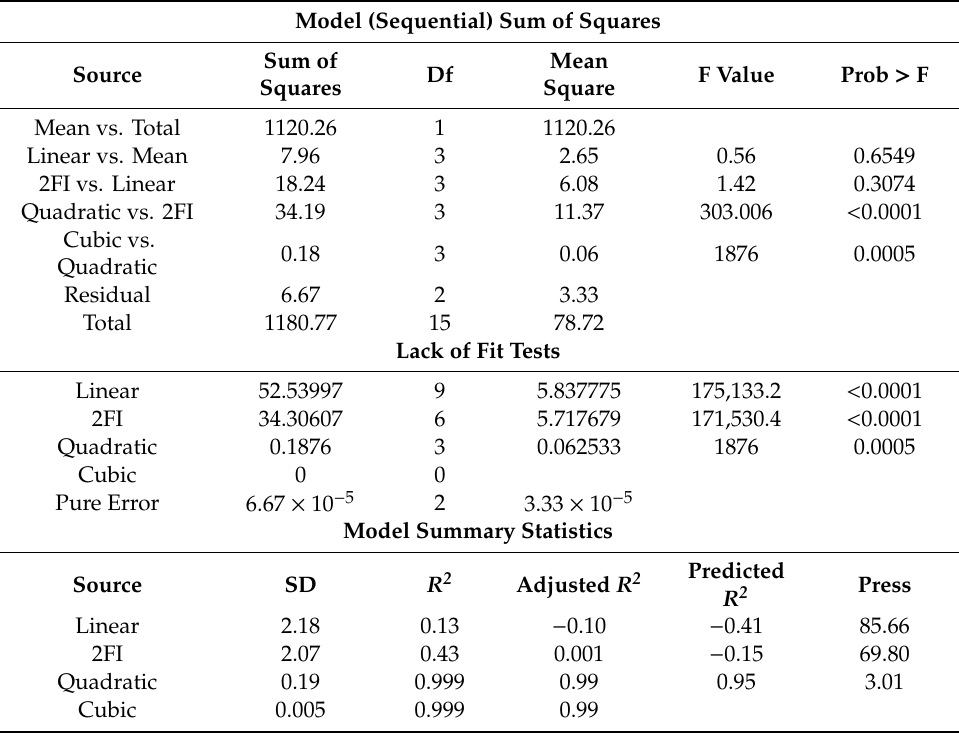
Table 2. Sequential model fitting for the yield of polysaccharide. Model (Sequential) Sum of